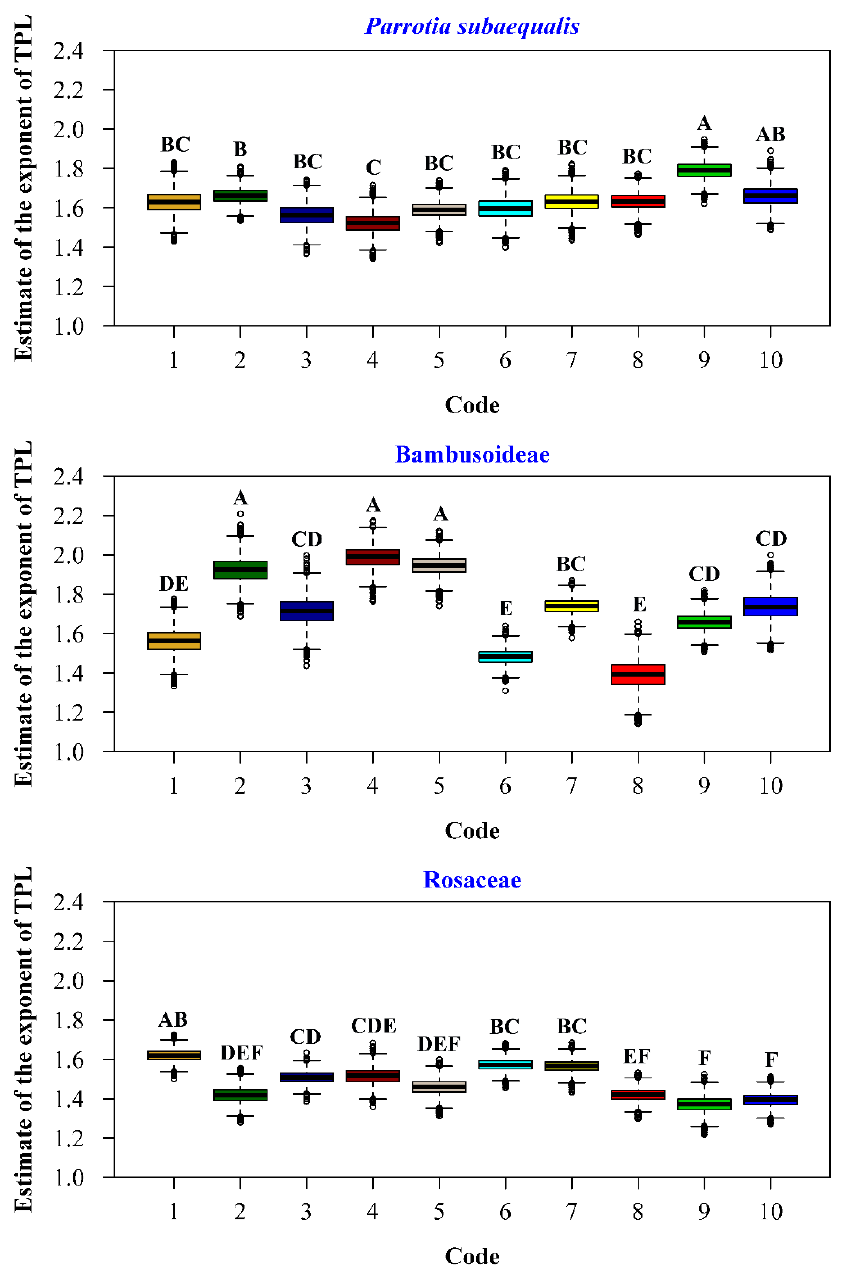
Figure 3. Boxplots of the estimates of the exponent of Taylor’s power law (TPL) for three classes of plants. The values forming the box were calculated using 4000 bootstrap replications. The letters on the top of the boxes are used to indicate significant differences between pairs of plants. Codes sharing the same letter(s) indicate no significant difference; otherwise, there is a significant difference. The significance tests were obtained using the bootstrap percentile method.